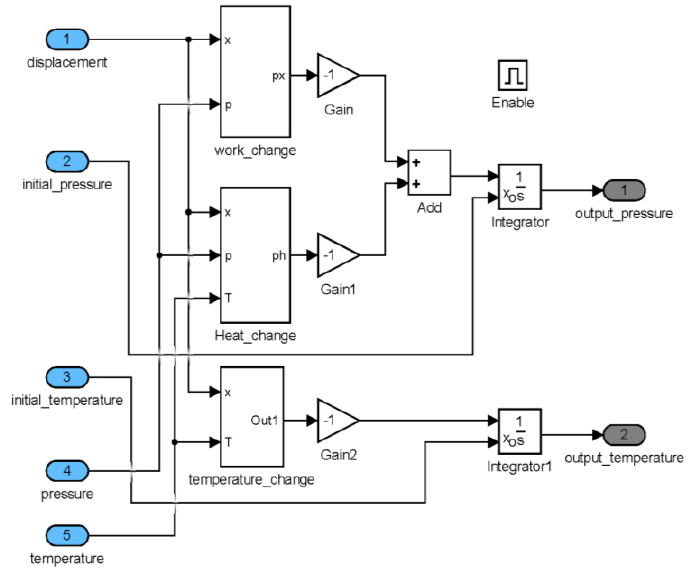
Figure 3. Simulink diagram for the simulation.